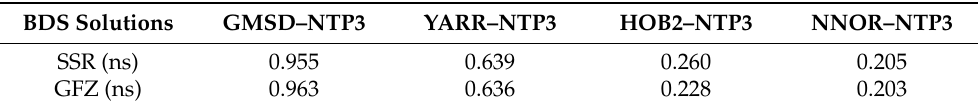
Figure 7. BDS results for SSR and GFZ solutions. Table 5. RMS of BDS results for the time links (ns).